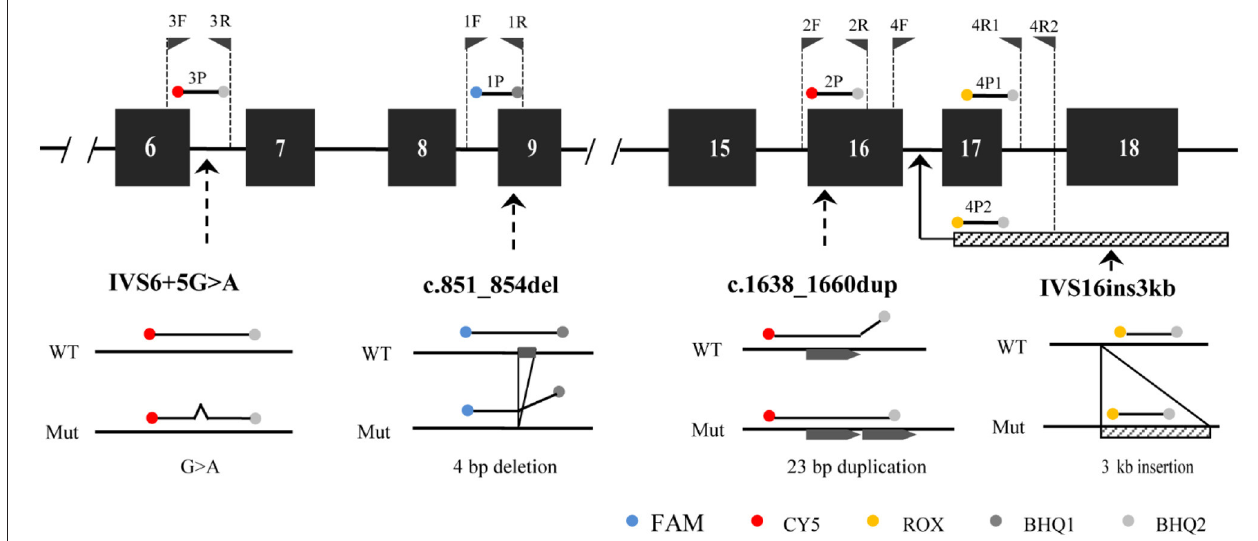
FIGURE 1 | The principle of MMCA assay for the detection of the four prevalent SLC25A13 mutations. The relative positions of the four designed primer-probe sets within the SLC25A13 gene are marked. MMCA, multicolor melting curve analysis.